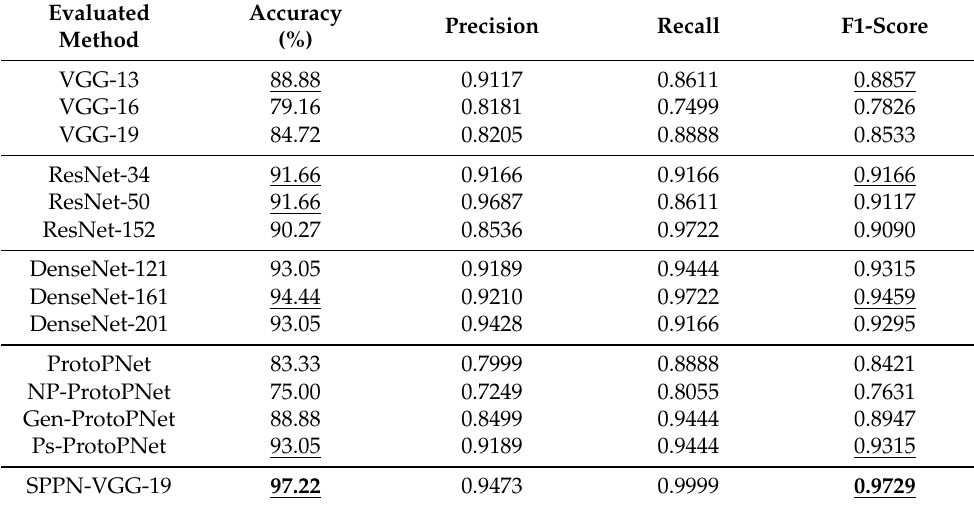
Table 4. Benchmarking evaluation.